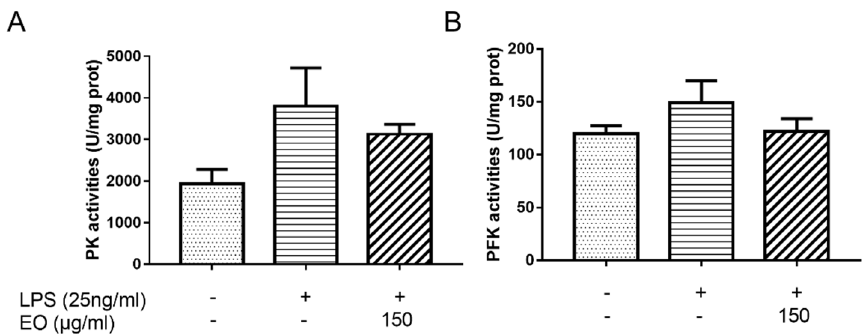
Figure 6. Measurement of the EO on PK ( A ) and PFK ( B ) activities in BV2 microglial cells. All tests were performed in triplicate. All tests were performed in triplicate.